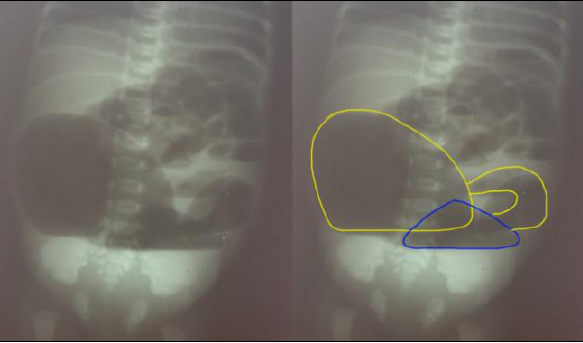
Figure 1: Radiological film demonstrating type 5 CPC. (Left- unedited; right- presumable gas shadows of double pouch colon with short normal inter-positioned colon segment).